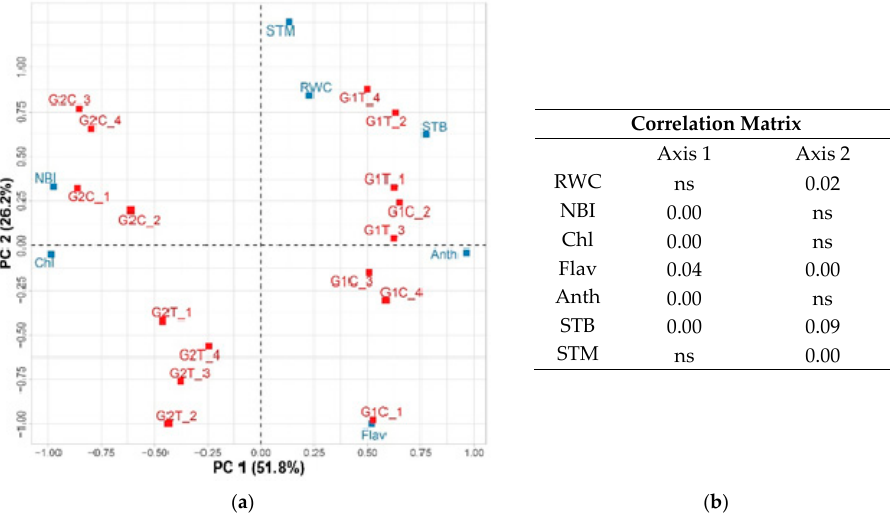
Figure 2. ( a ) PCA analysis of Narvik (G1) and Gružanski zlatni (G2) tomato cultivars, grown in the polytunnel without (C) or with T. harzianum application (T), involving chlorophyll (Chl), epidermal flavonols (Flav), nitrogen balance index (NBI), anthocyanin (Anth), relative water content ( RWC (%)), stem diameter base ( STB (cm)) and stem diameter middle (STM (cm)). ( b ) Correlation matrix (Pearson’s product correlation coefficient) with the associated p value between the principal components and the analyzed variables.